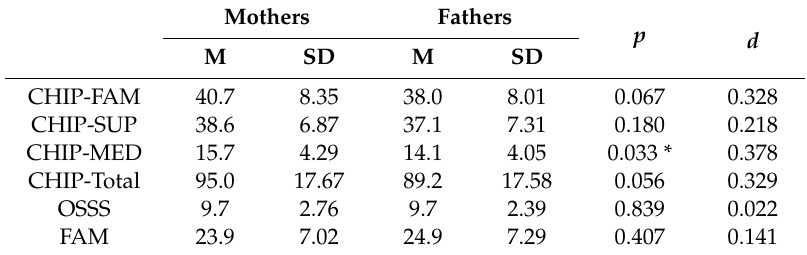
Table 4. Distribution of coping, social support and family functioning of parents of children and adolescents with rare diseases requiring mechanical long-term ventilation and comparison of mothers and fathers. Mothers Fathers p d M